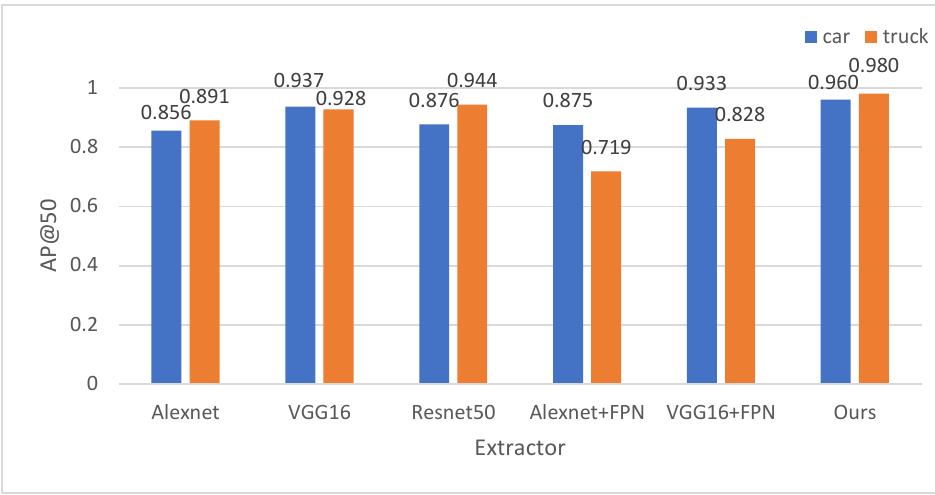
Figure 15. The comparison results of the proposed detection method with Faster-RCNN using other extractors on